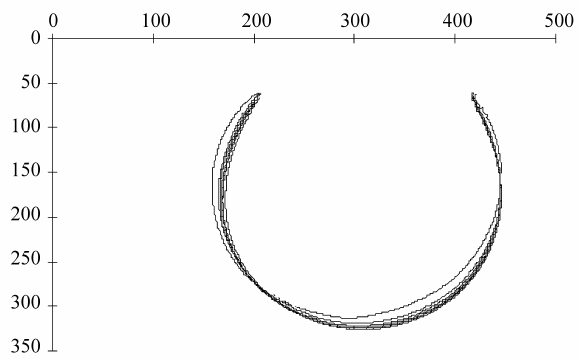
Figure 5. Evolution of the profile of a drop of polystyrene (Mn = 200,000 g/mol) in low density polyethylene at 202 °C.